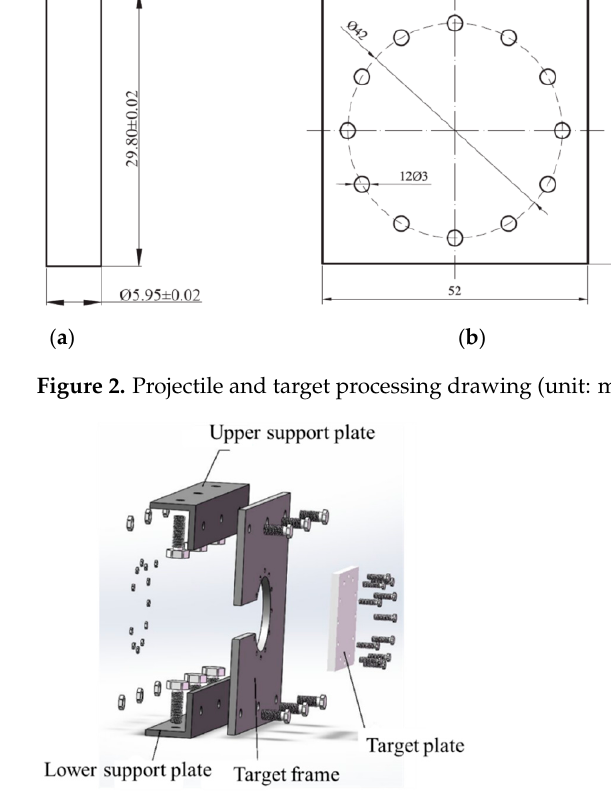
Figure 3. The assembly pattern of target and support frame.